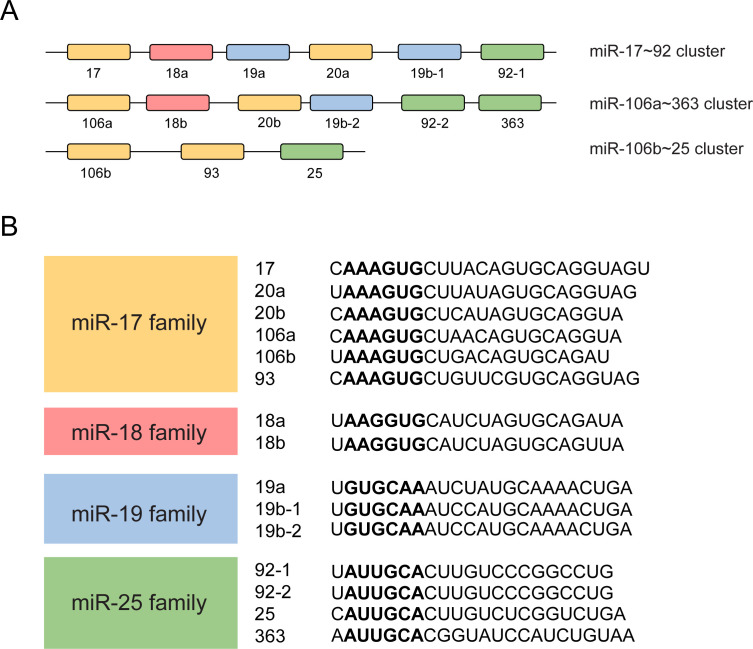
Schematic representation of the miR-17~92 family miRNAs.(A and B) Schematic representation of three miRNA clusters of miR-17~92 family miRNAs (A) and their target sequences (B). The mature miRNAs in different families are shown in different colors. Yellow: members of the miR-17 family; Red: members of the miR-18 family; Blue: members of the miR-19 family; Green: members of the miR-25 family. The ‘seed region’ of each mature miRNA is shown in bold format.